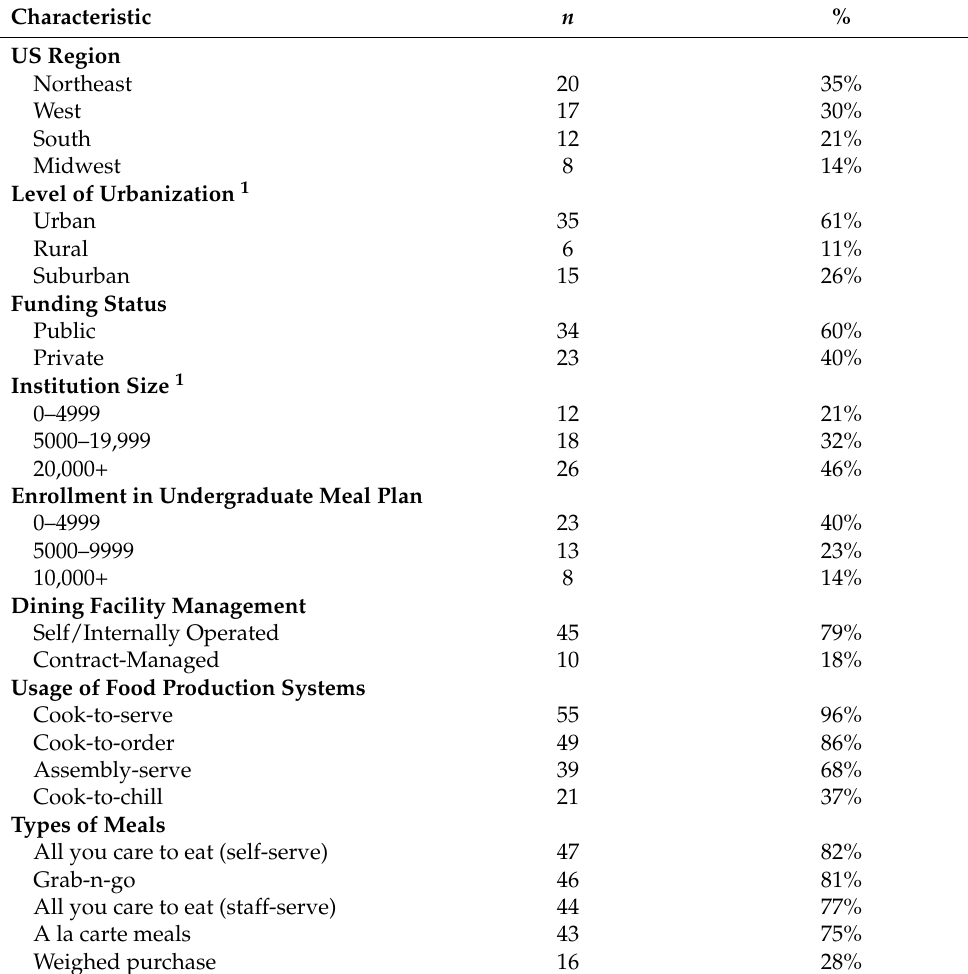
Table 1. Characteristics of sampled institutions ( n =